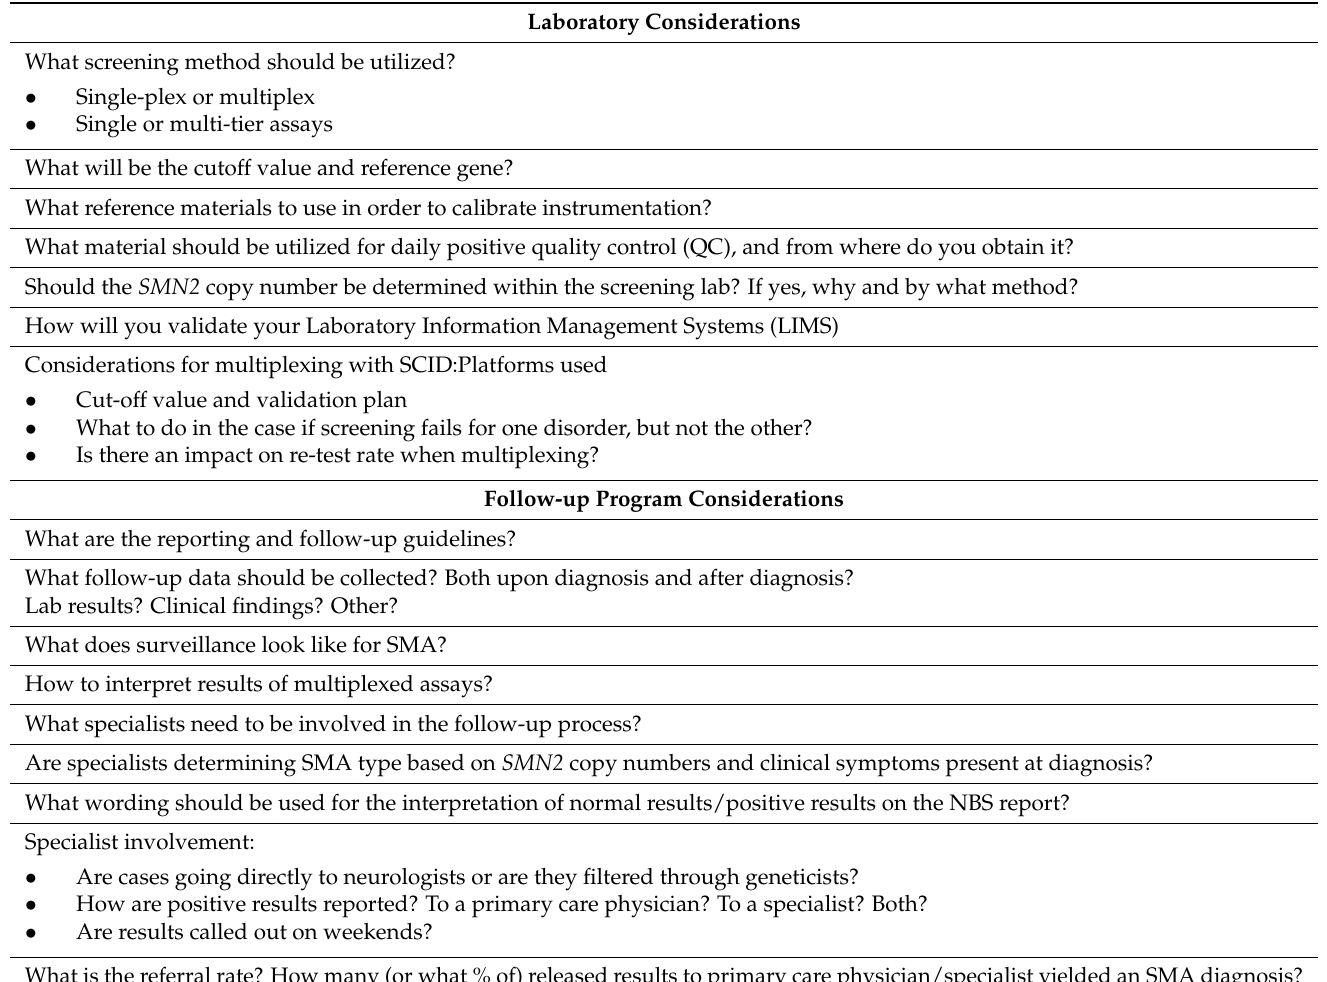
Table 2. Laboratory and follow-up screening considerations and questions for